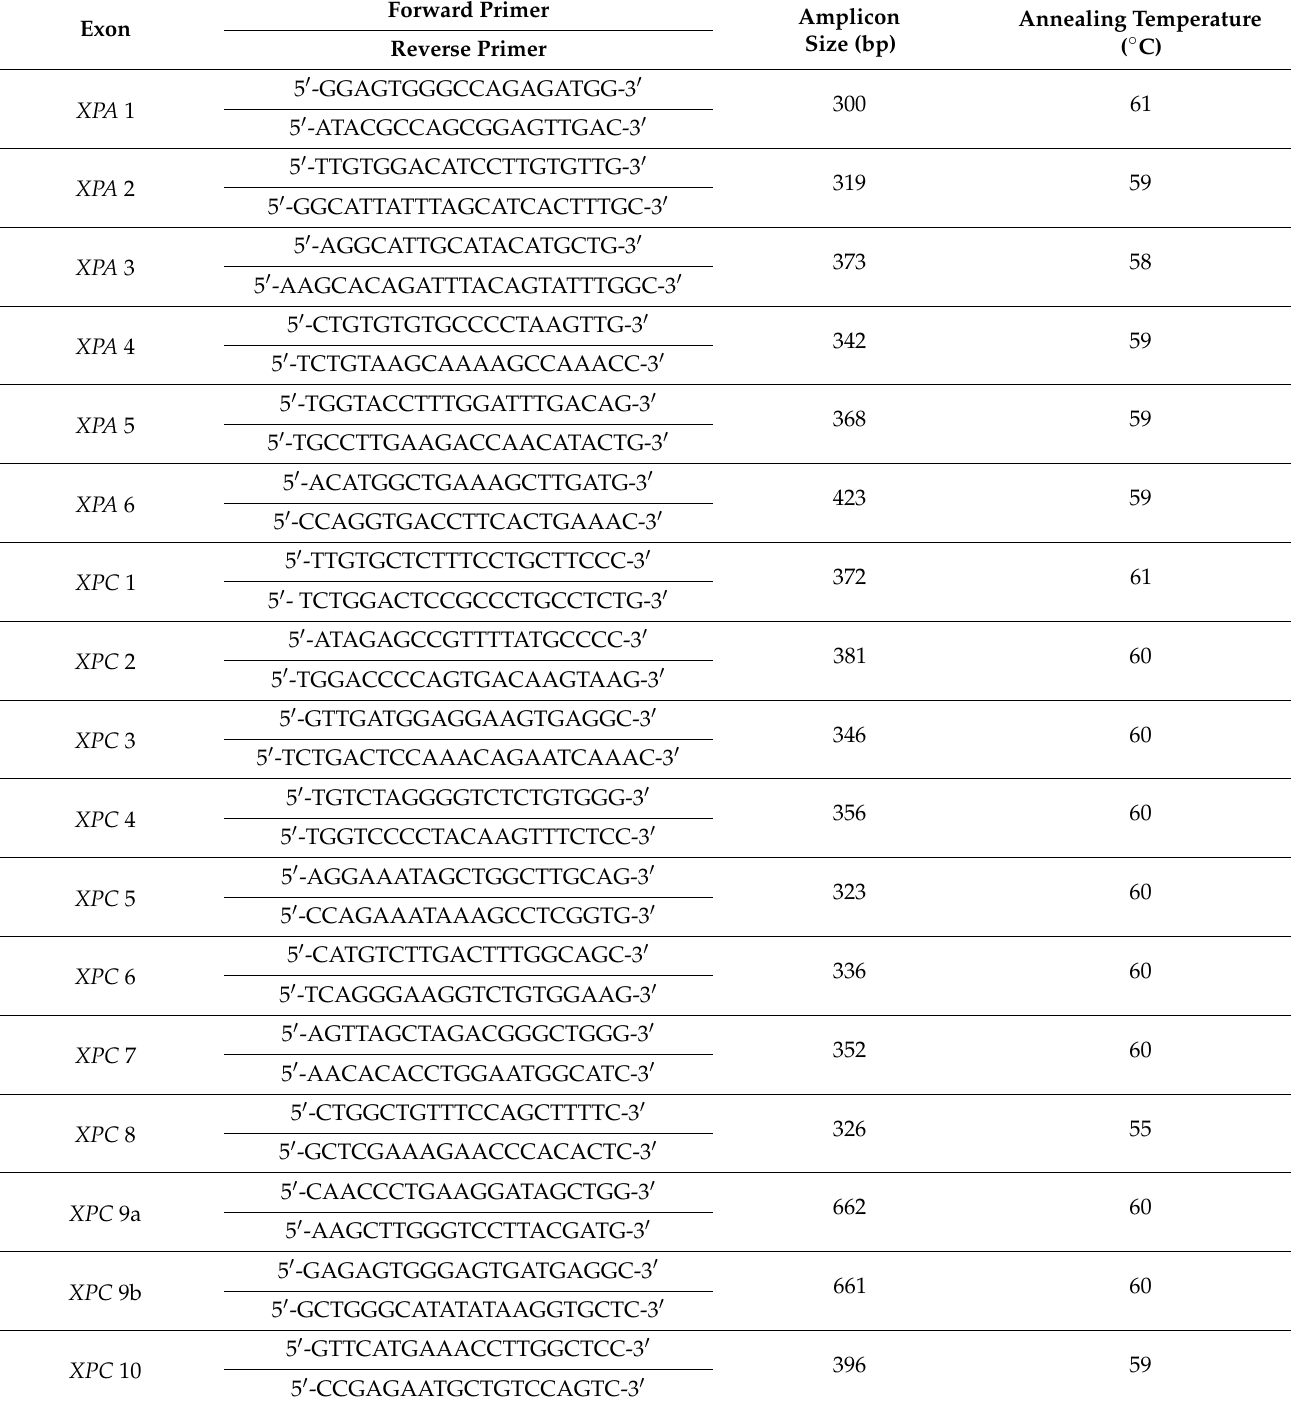
Table 1. Primer pairs used for amplification of XPA and XPC